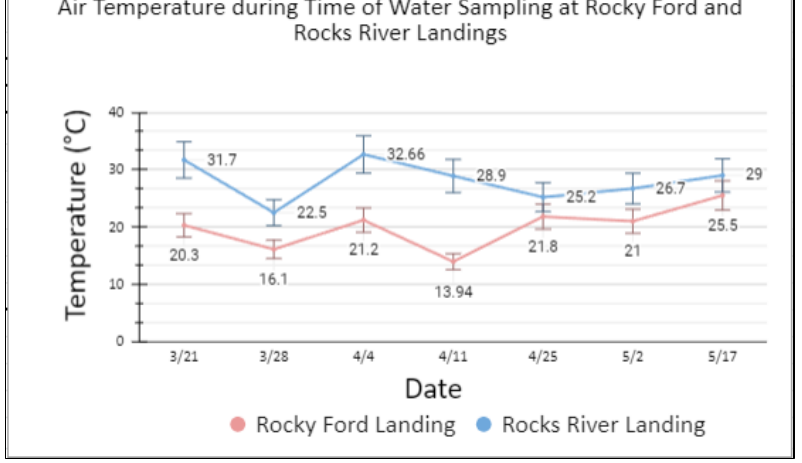
Figure 7. Water Quality — Air Temperature in Degree Celsius from March – May 2022.